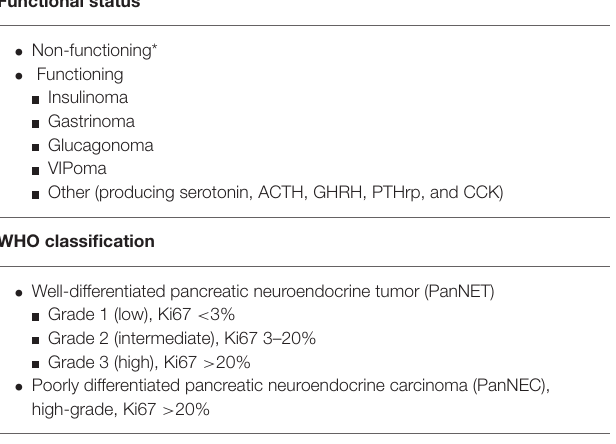
TABLE 1 | Pancreatic neuroendocrine neoplasm classification according to functional status and WHO classification (1). Functional